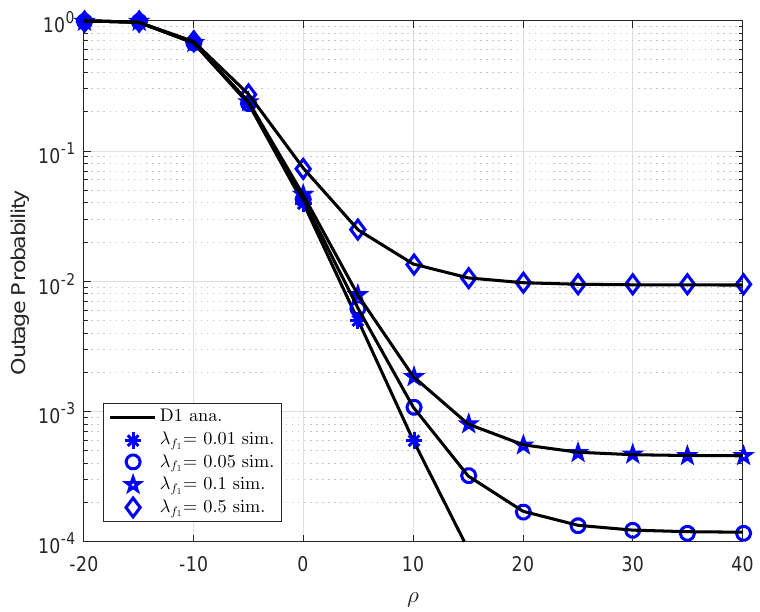
Figure 6. Outage behavior of user D 1 versus ρ as varying λ f